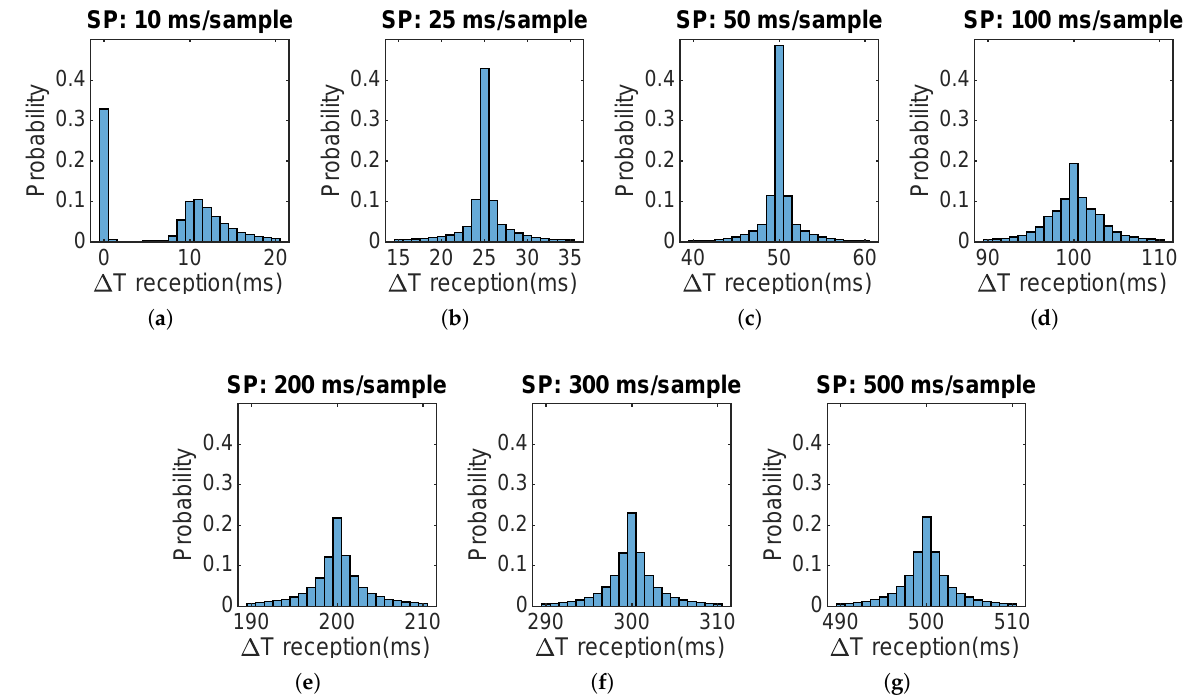
Figure 9. Histogram of reception time difference for each sampling period, indicated in the histogram title ( a – g